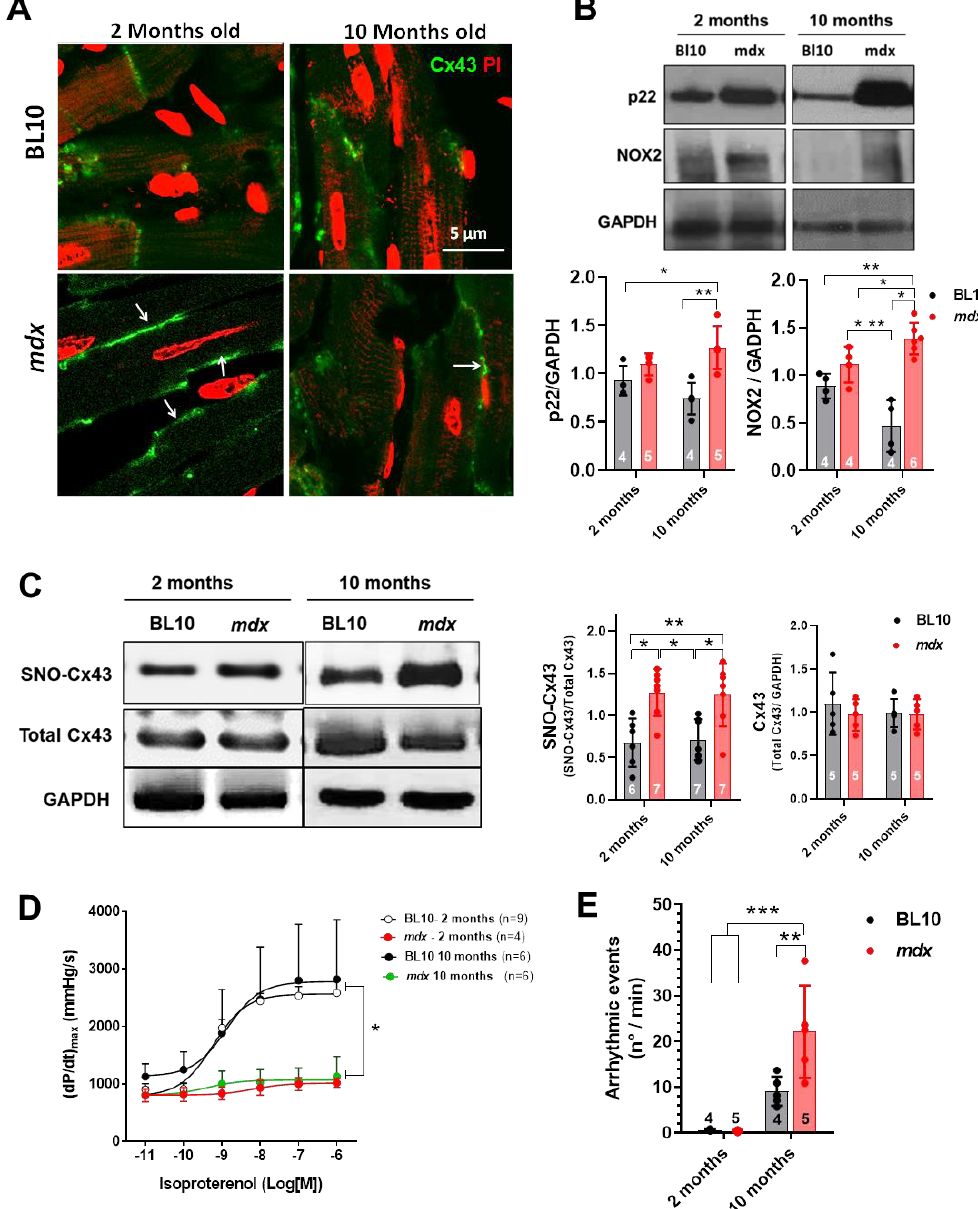
Figure 1. Connexin 43 location S-nitrosylation and NOX2 expression in dystrophic hearts at 2 and 10 months of age. ( A ) Panel of representative confocal images of cardiac sections of control and mdx mice for Cx43 and counterstained for nuclei (propidium iodide, PI). The arrows indicate lateralized Cx43. ( B ) Western blot analysis for the NADPH oxidase-2 subunits p22 and NOX2. The upper